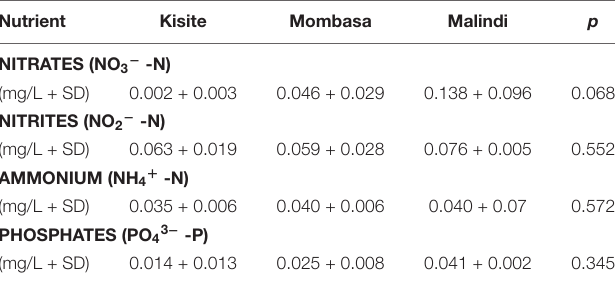
TABLE 2 | Nutrient levels measurements of the three coral reefs within the marine national parks at the time of sampling for microbiome sequencing. Nutrient